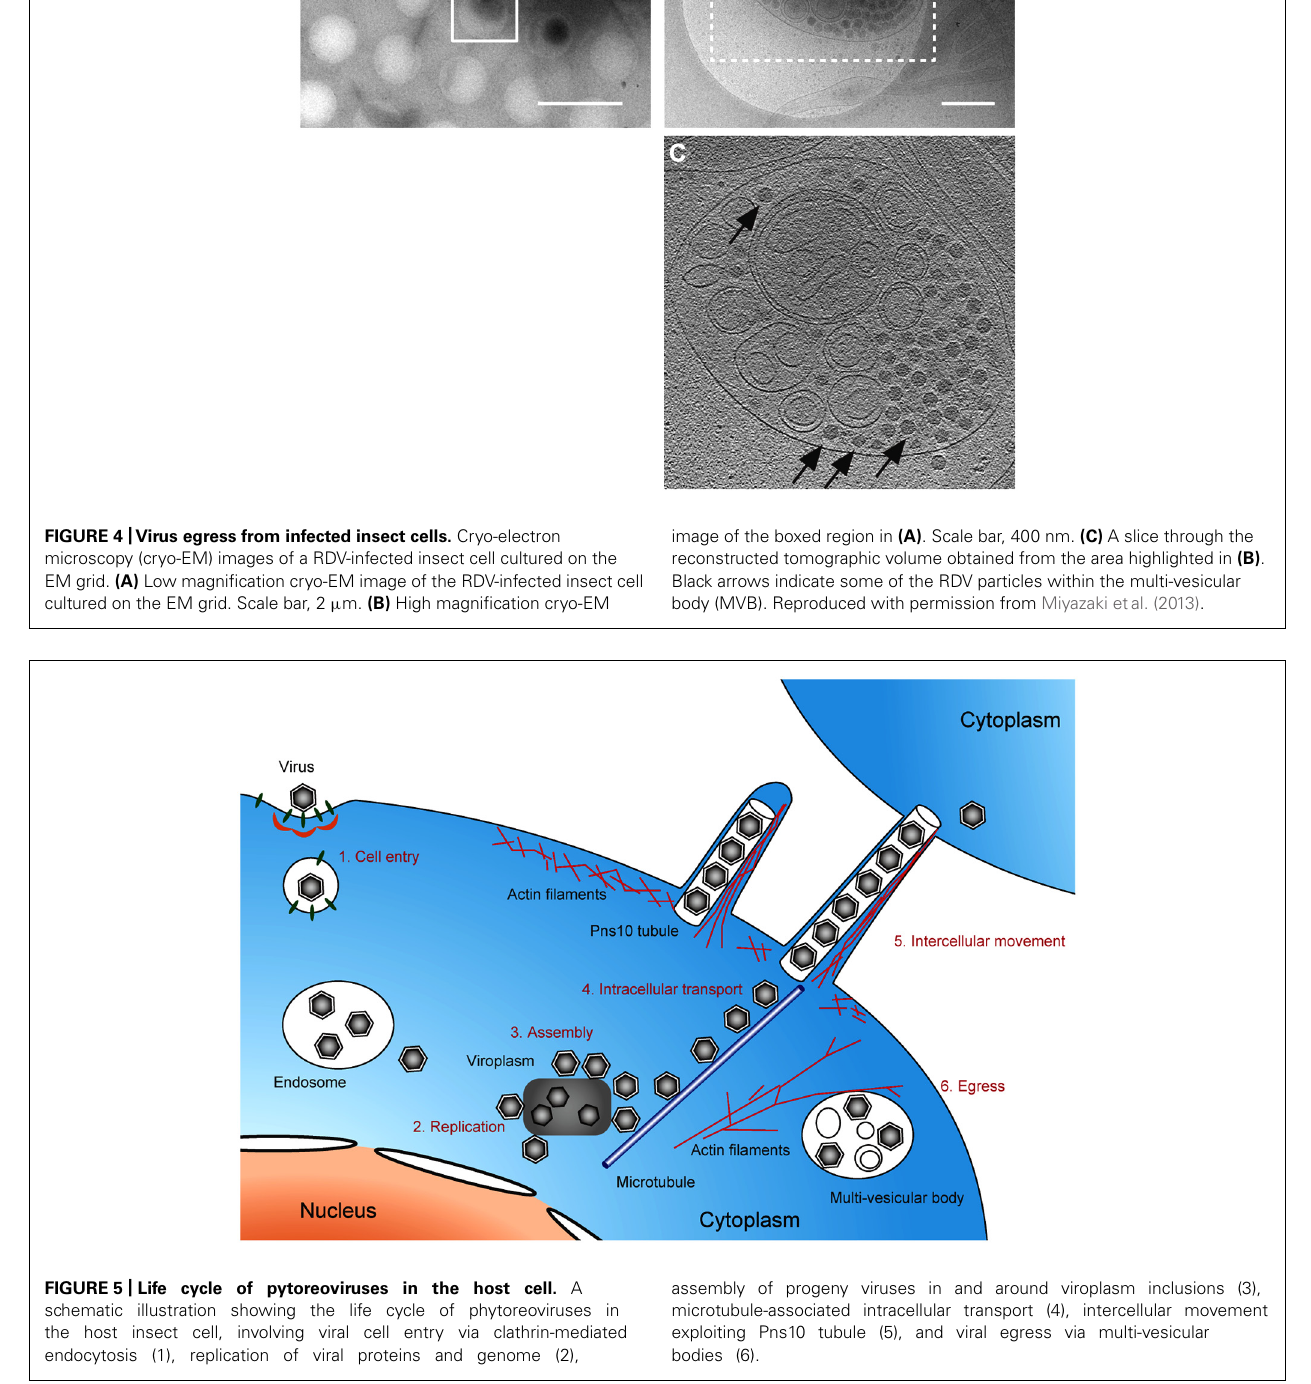
FIGURE 5 | Life cycle of pytoreoviruses in the host cell. A schematic illustration showing the life cycle of phytoreoviruses in the host insect cell, involving viral cell entry via clathrin-mediated endocytosis (1), replication of viral proteins and genome (2),